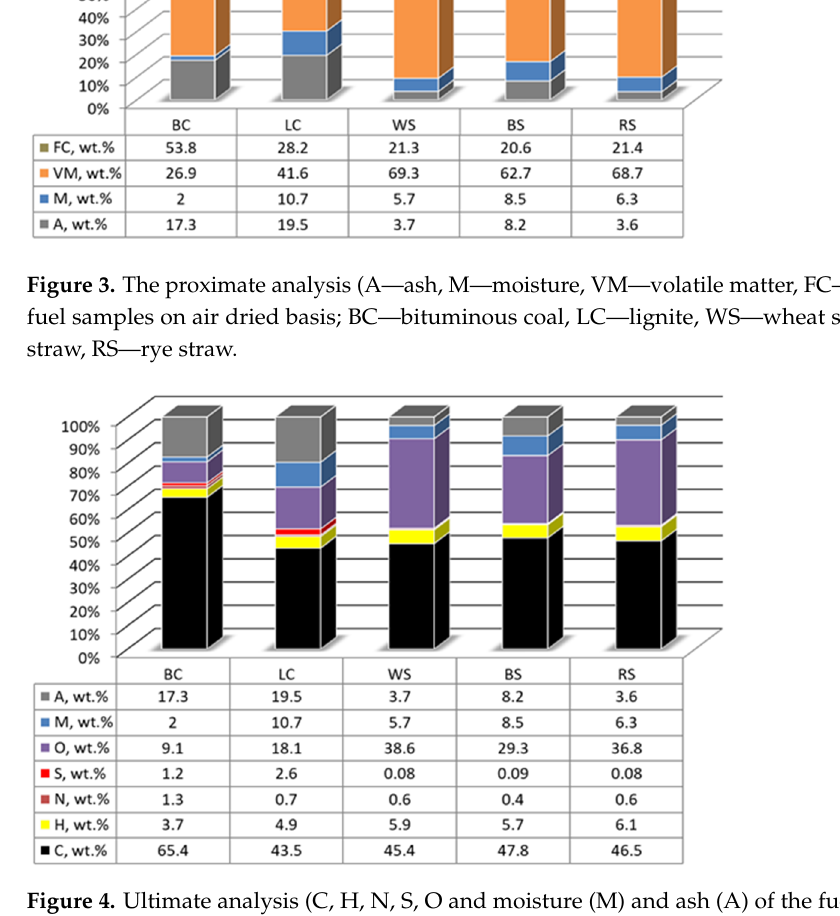
Figure 4. Ultimate analysis (C, H, N, S, O and moisture (M) and ash (A) of the fuel samples on air dried basis; BC—bituminous coal, LC—lignite, WS—wheat straw, BS—barley straw, RS—rye straw.